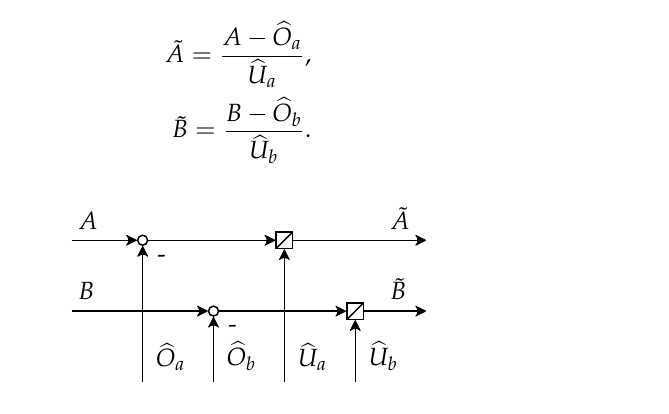
Figure 3. Scheme of the error correction.